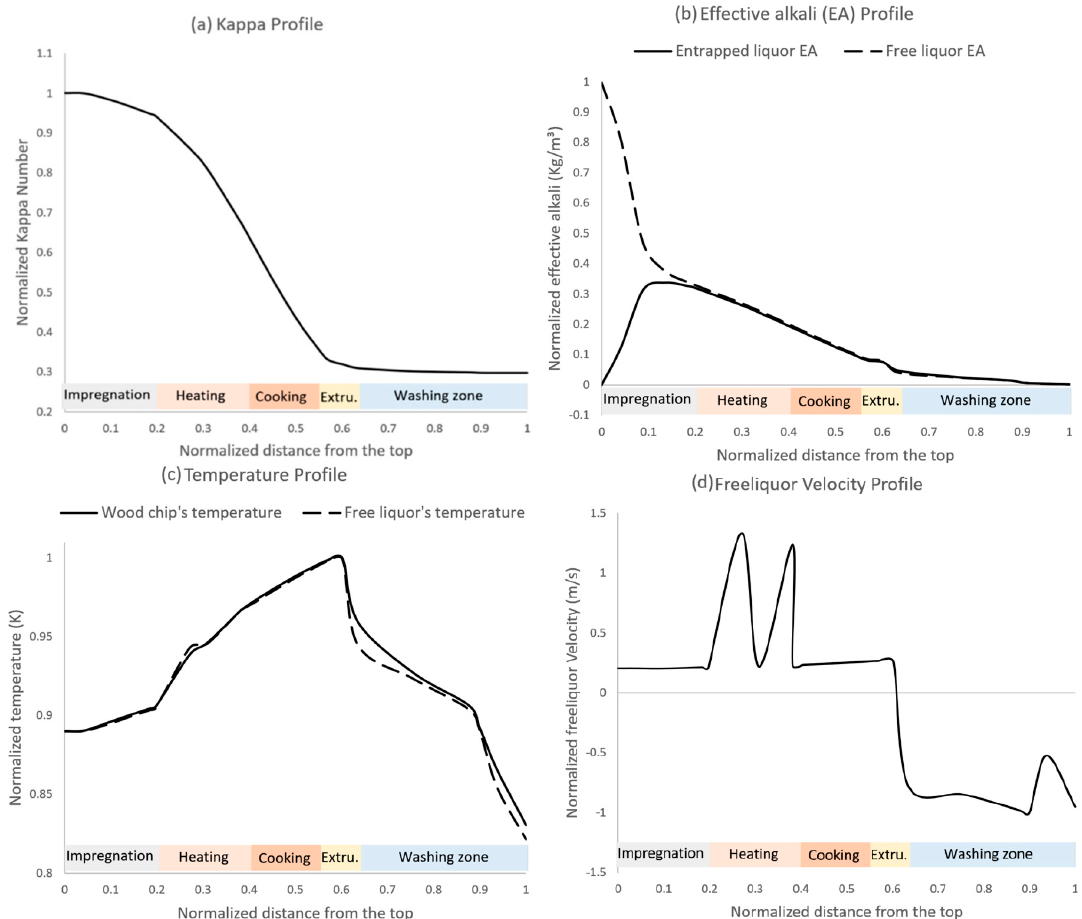
Figure 4. Spatial development of major process variables in the direction of chip flow. ( a ) Kappa number, ( b ) EA, ( c ) temperature and ( d ) free liquor velocity.